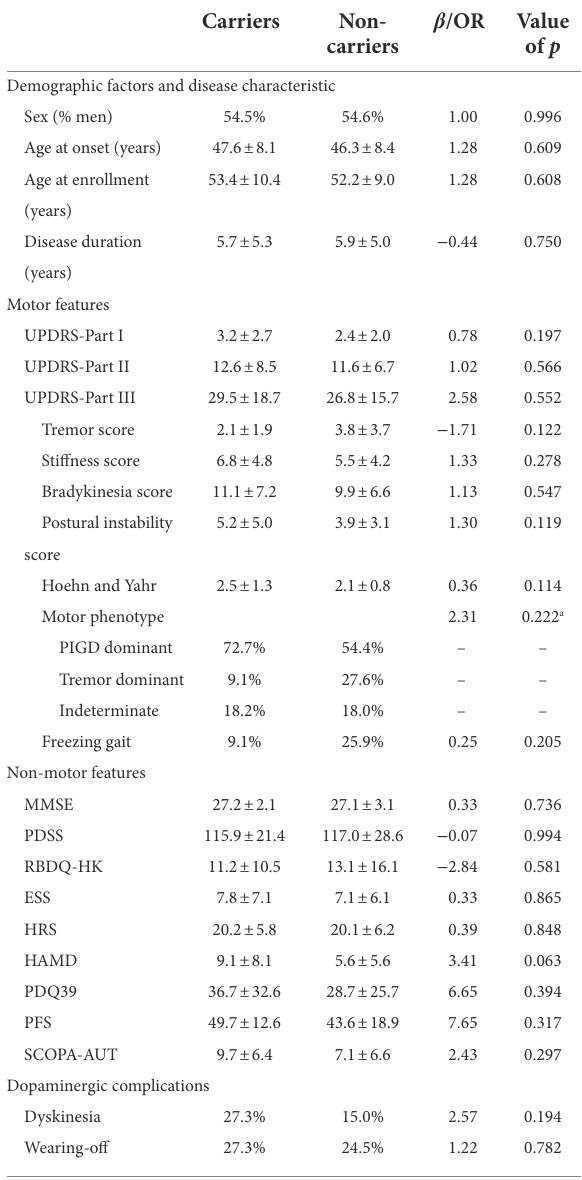
TABLE 3 Comparison of clinical features in carriers and non-carriers of NOTCH3 variants. Clinical